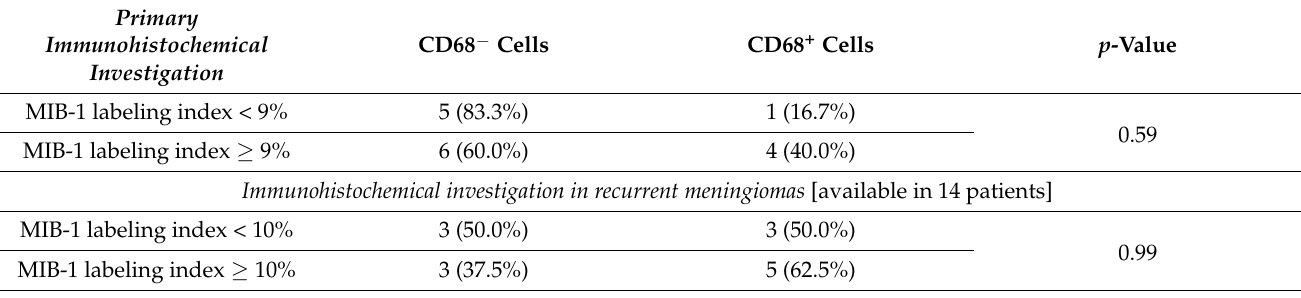
Table 2. MIB-1 labeling index and CD68-positive macrophage infiltrates.